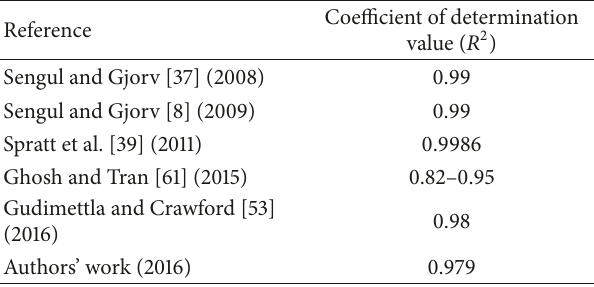
Table 7: Coefficient of determination (COD) value for linear trend between bulk and surface resistivity in the literatures. Coefficient of determination Reference value ( 𝑅 2 ) Sengul and Gjorv [37] (2008) 0.99